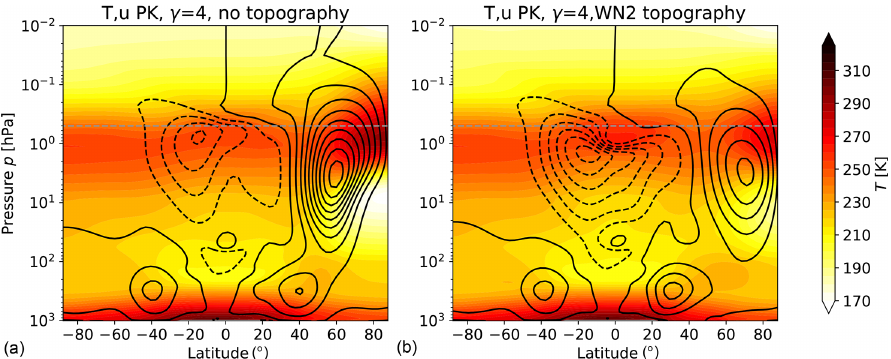
Figure 4. Climatologies of wind (black contours, contour interval is 10ms − 1 ; solid indicates positive and dashed negative) and temperature (K) (colored contours) of (a) an EMIL simulation with the PK02 setup with γ = 4Kkm − 1 and (b) an EMIL simulation with the PK02 setup with γ = 4Kkm − 1 and with WN2 topography with h = 3km. The gray dashed horizontal lines in the EMIL climatologies mark the lower boundary of the damping layer. Averages are performed over 10000d.